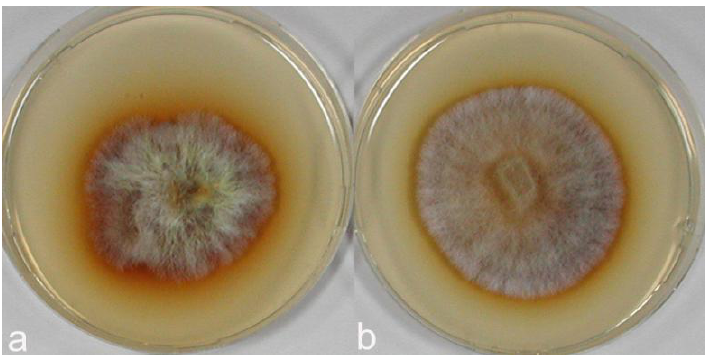
Figure 9. Polyphenol oxidase activity of C . aff. radians ( a ) strain 1-1C and ( b ) strain 1-2PS at day 7 of growth on MEA with gallic acid (pH 6.0) at 25 °C.